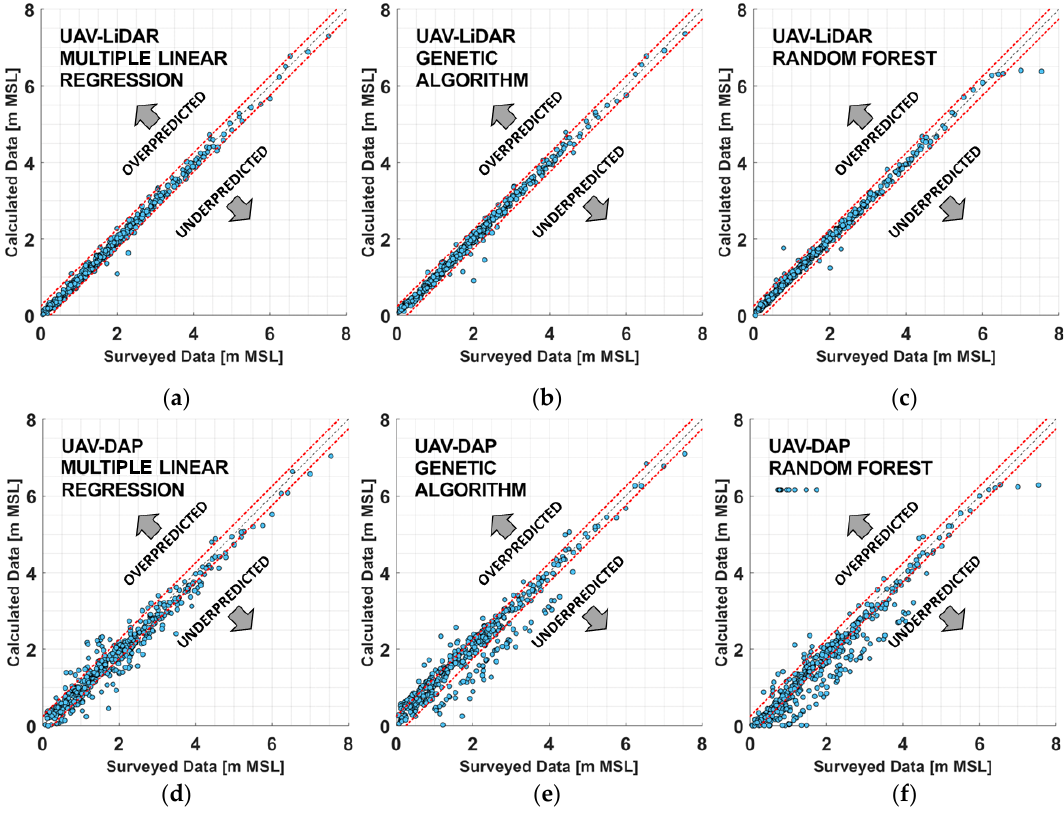
Figure 7. Scatter plots comparing the surveyed (on the abscissa axis) and the calculated (on the or- dinate axis) ground elevation data. The data are calculated by applying the multiple linear regres- sion ( a – d ), the genetic algorithm ( b – e ), and the random forest ( c – f ) to the UAV – LIDAR (first row) and the UAV – DAP (second row) point clouds. The red dashed lines indicate an estimation error of ±0.25